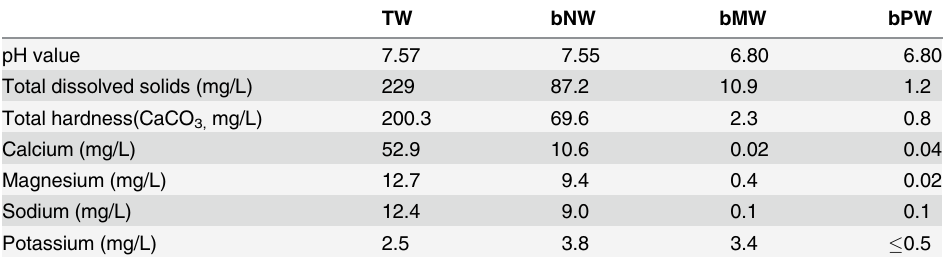
Table 1. Main mineral element contents and pH values of the four types water.